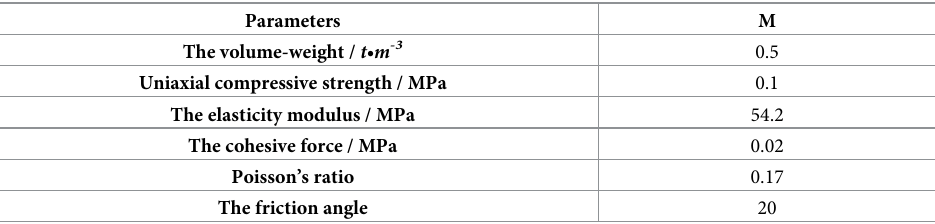
Table 3. Laboratory test properties of the